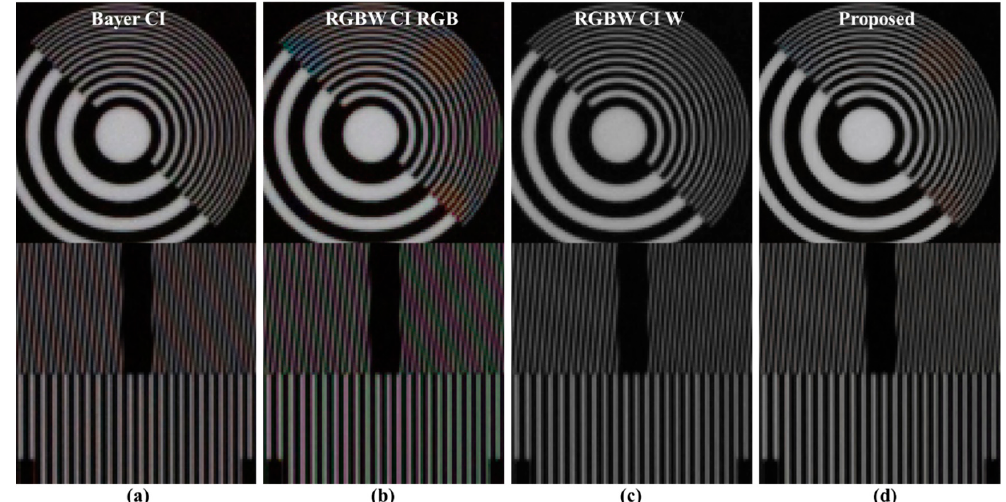
Figure 11. Comparisons of color aliasing artifacts and spatial resolutions: ( a ) Bayer CFA demosaicing results [19]; ( b ) RGB channels of Sony RGBW CFA demosaicing results [24]; ( c ) W channel of Sony RGBW CFA demosaicing results; ( d ) proposed method post-processing results.